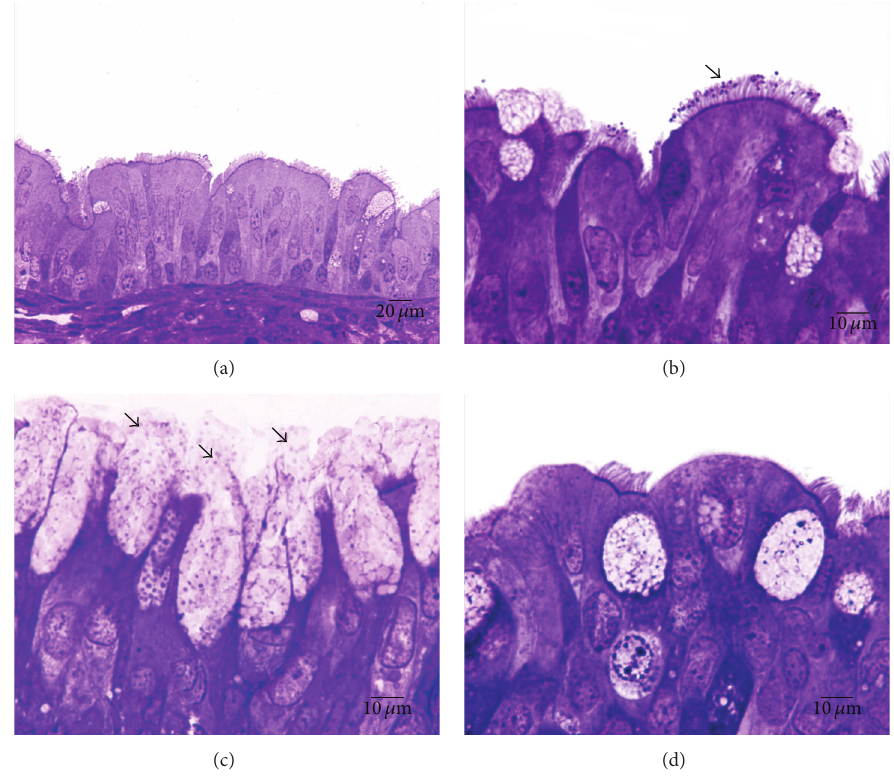
Figure 3: Toluidine blue staining of respiratory nasal epithelia of rabbit fetuses exposed to P. multocida . (a) Normal epithelium not exposed to bacteria or lectins; LM, scale bar = 20 𝜇 m. (b-c) Nasal septa of positive control tissues exposed only to P. multocida . (b) P. multocida adhering to cilia (arrow); LM, scale bar = 10 𝜇 m. (c) GCs showing increased numbers and excretory activity. All of the GCs are protruding above the apical limit of their neighboring cells and liberating their contents (arrows); LM, scale bar = 10 𝜇 m. (d) Nasal epithelium exposed to both bacteria and PNA. The lectin inhibited the increase in the number of GCs, though some loss of cilia can still be observed; LM, scale bar = 10 𝜇 m.